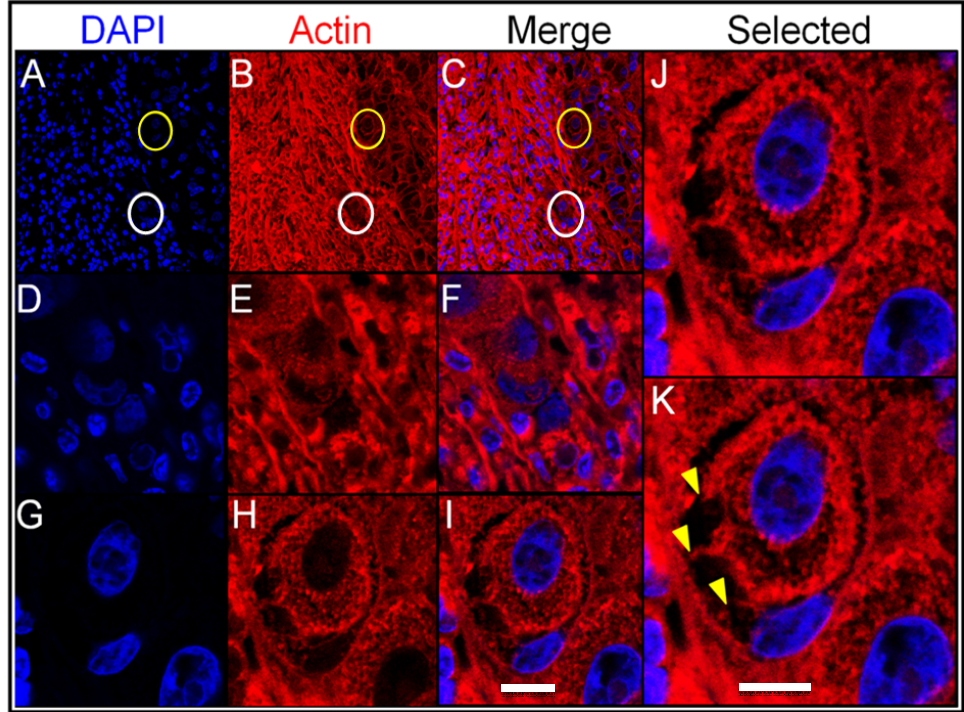
Figure 5. Confocal analysis of entotic figures in the lymph node metastasis. ( A – C ) A general view of the entotic cells stained with DAPI (nuclei; panel ( A )) and phalloidin Atto ‐ 647N (actin; panel ( B )); panel ( C ) shows panels ( A , B ) merged; circles indicate entotic figures; 10× microscope objective. ( D – F ) Magnified images of the entotic figure from panels ( A – C ) (white circle); entotic cells stained with DAPI (nuclei; panel ( D )) and phalloidin Atto ‐ 647N (actin; panel ( E )); panel ( F ) shows panels ( D , E ) merged; 40× microscope objective. ( G – I ) Magnified images of the entotic figure from panels ( A – C ) (yellow circle); entotic cells stained with DAPI (nuclei; panel ( G )) and phalloidin Atto ‐ 647N (actin; panel ( H )); panel ( I ) shows panels ( G , H ) merged; 40× microscope objective. ( J , K ) Magnified images of the entotic figure from panel ( I ). The arrowheads (panel ( K )) indicate cytoplasmic bridges between the inner and outer entotic cell; 40× microscope objective. Scalebar 10 μ M.